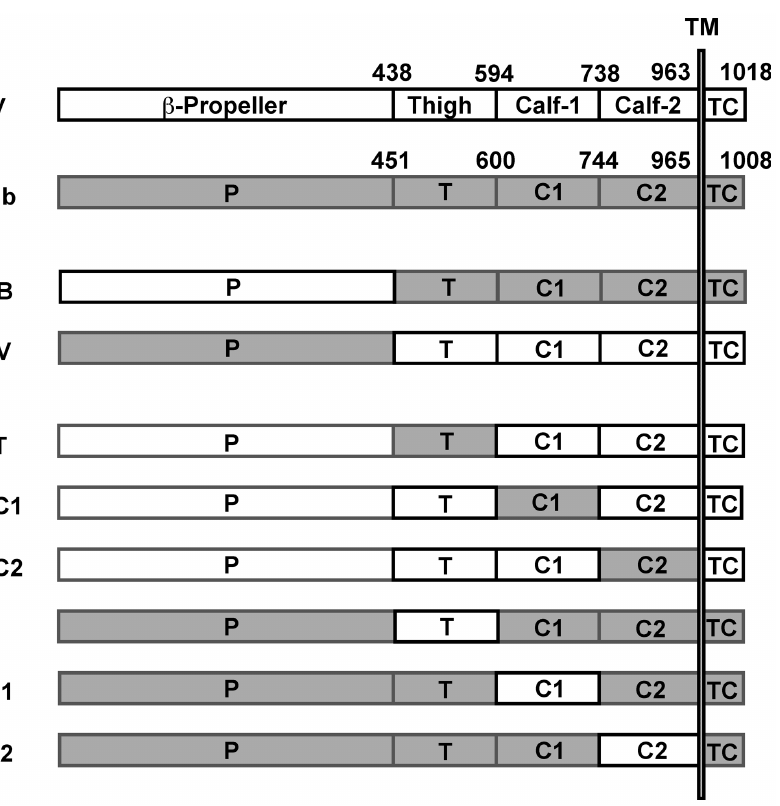
Figure 1. Schematic representation of a V/ a IIb chimeras. The abbreviations P, T, C1, C2, and TC in the figure stand for b -propeller, thigh, calf-1, calf-2, and transmembrane-cytoplasmic domain, respectively. The numbers indicate the domain boundaries used to create the chimeras.